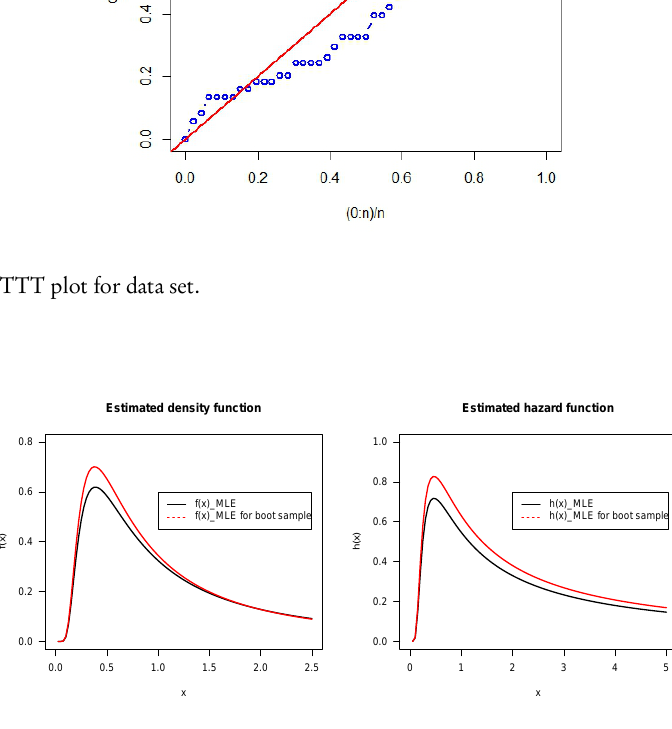
Figure 8 – Estimated plots for the considered data set.